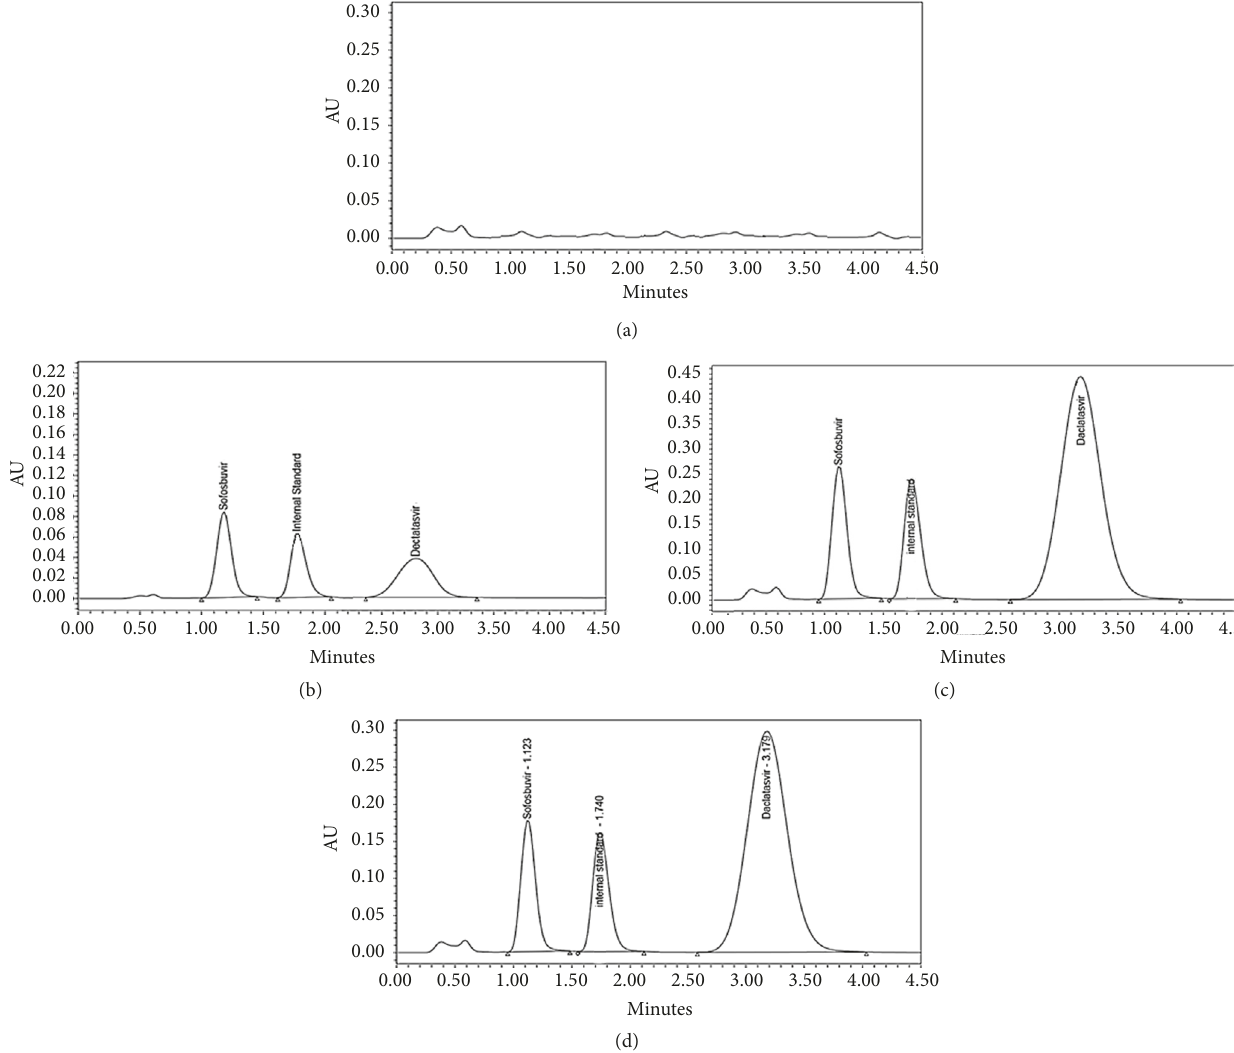
Figure 2: Typical UPLC chromatograms of (a) drug-free human plasma; (b) blank plasma spiked with SF and DC at LLOQ, (c) blank plasma spiked with SF and DC at ULOQ, and (d) plasma sample from a volunteer 0.5 h after administration of Darvoni (cid:2) (400 mg of SF/60 mg of